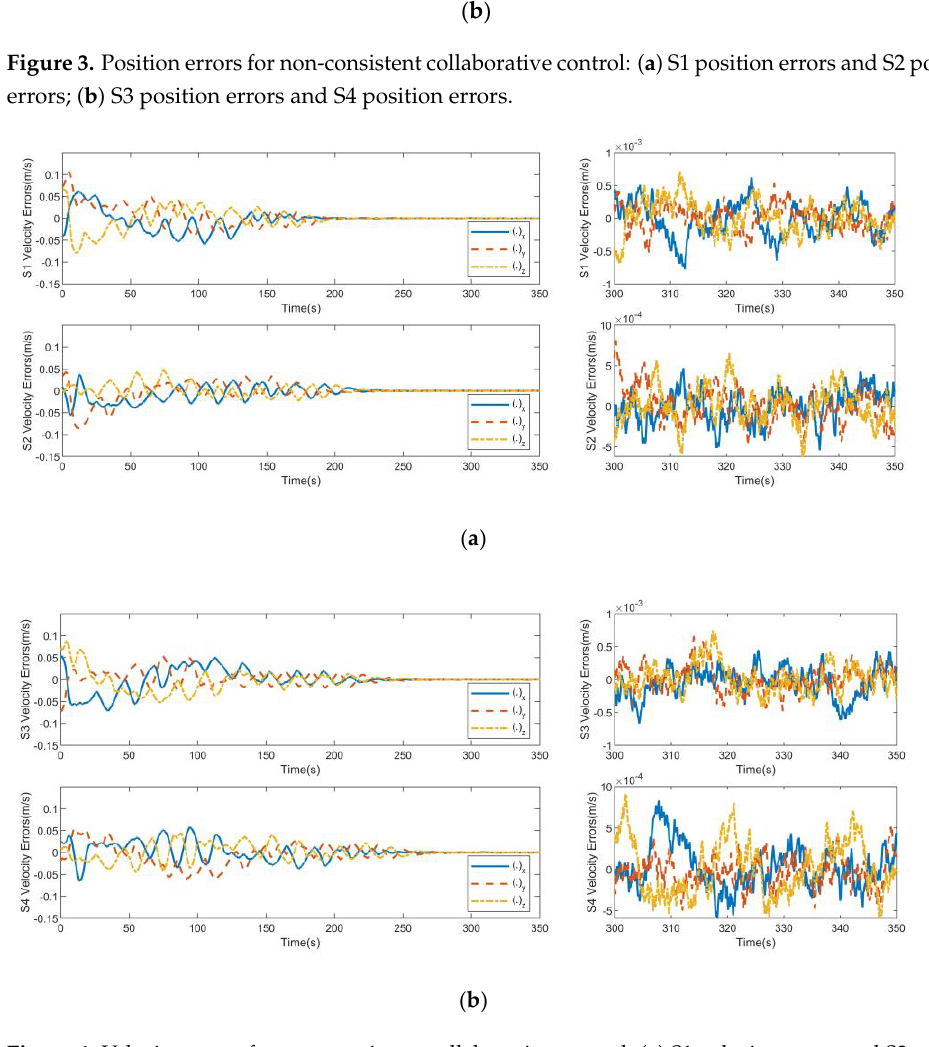
Figure 4. Velocity errors for non-consistent collaborative control: ( a ) S1 velocity errors and S2 veloc- ity errors; ( b ) S3 velocity errors and S4 velocity errors.